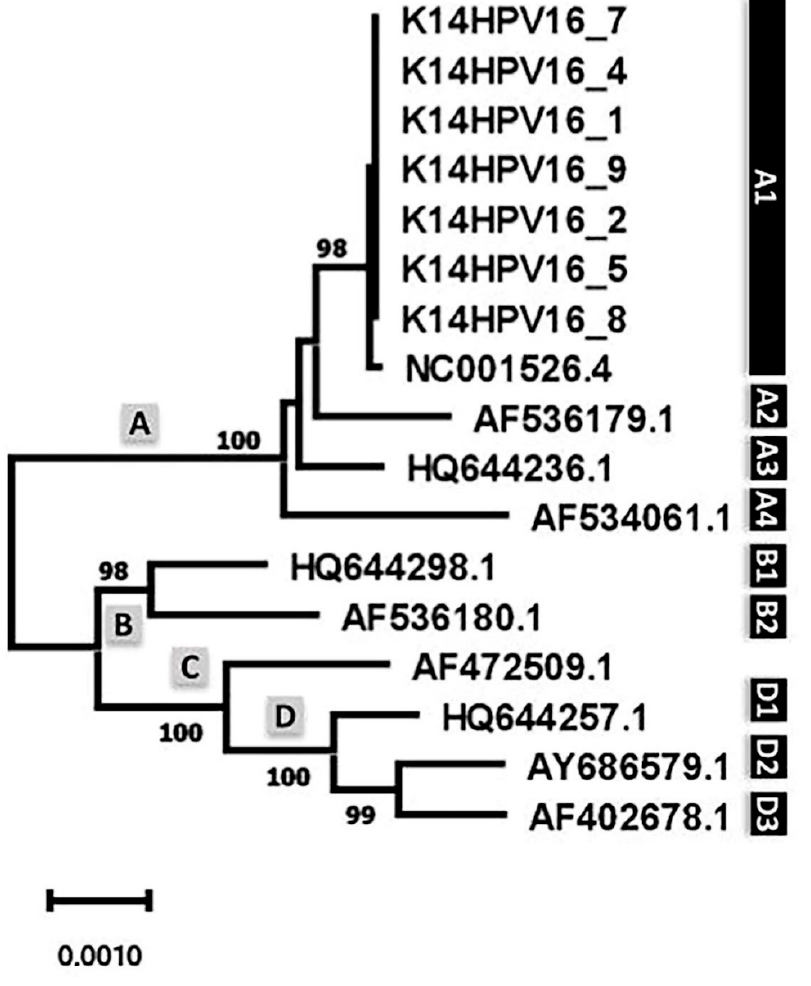
Figure 3. Phylogenetic positioning of K14HPV16 samples within the major HPV16 lineages (A–D). Legend: the phylogenetic tree was generated using the neighbor-joining method [18] with the maximum composite likelihood model [17] and depicts the genetic relationships of the obtained K14HPV16 genome consensus sequences to each representative genome. Numbers next to the branch nodes indicate the bootstrap values (1000 replicates). HPV16 lineages are shown in grey boxes next to the main tree branches, while sublineages (A1–A4, B1, B2, and D1–D3) are illustrated in black